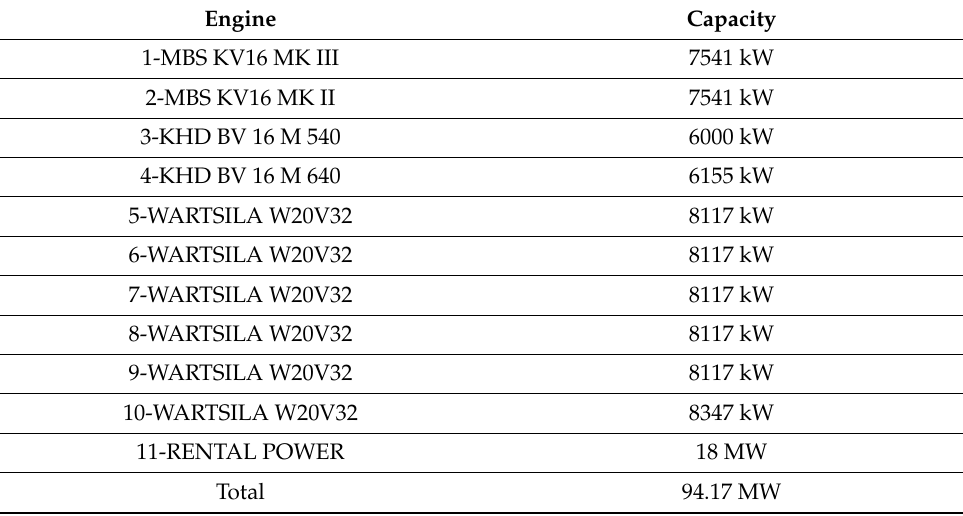
Table 1. The capacity of diesel generators at Duqm.